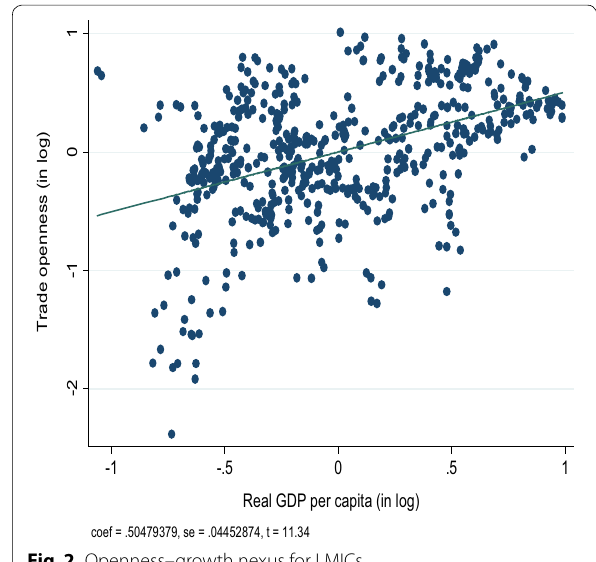
Fig. 2 Openness–growth nexus for